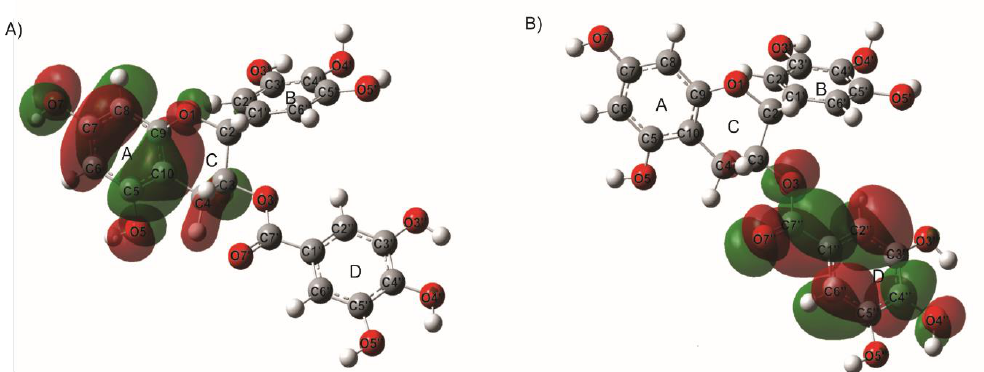
Figure 5. Localization of ( A ) HOMO and ( B ) LUMO molecular orbitals of epigallocatechin gallate (EGCG), calculated with B3LYP/6-31G (d,p) methodology.